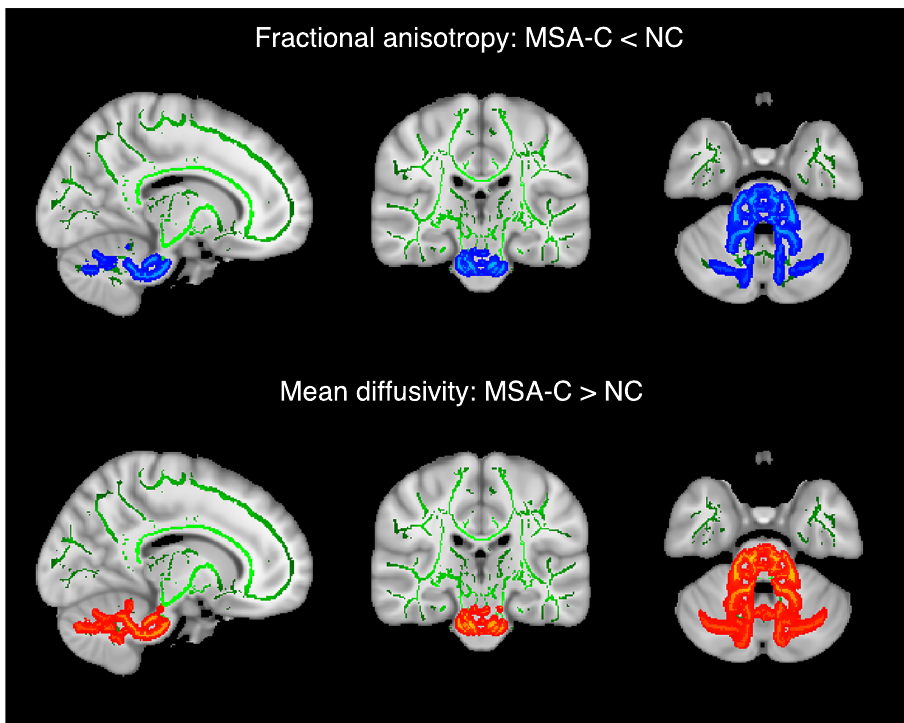
Fig. 3 Comparisons of fractional anisotropy and mean diffusivity between normal controls and MSA-C patients. Green curves are the skeletons of white matter tracts obtained from analysis of tract-based spatial statistics. Blue curves in the top row show portions of the skeletons where mean fractional anisotropy in the disease group was signi fi cantly smaller than the control group ( P < 0.01, TFCE and FWE corrected), and red curves in the bottom row show portions of the skeletons where mean diffusivity in the disease group was signi fi cantly greater than the control group ( P < 0.01, TFCE and FWE corrected). Note that a representative image slice is visualized, respectively, for sagittal, coronal and axial view, and the image right is the subject left in the second and third